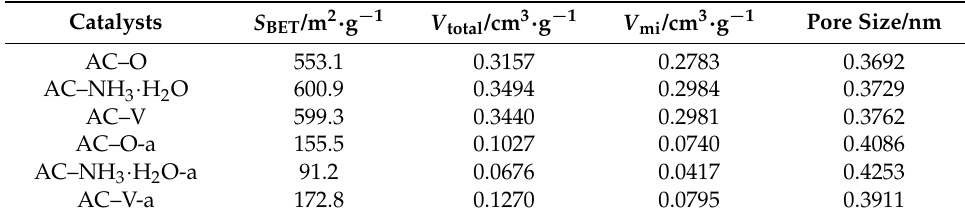
Table 1. Physical properties of AC–O and other catalysts.